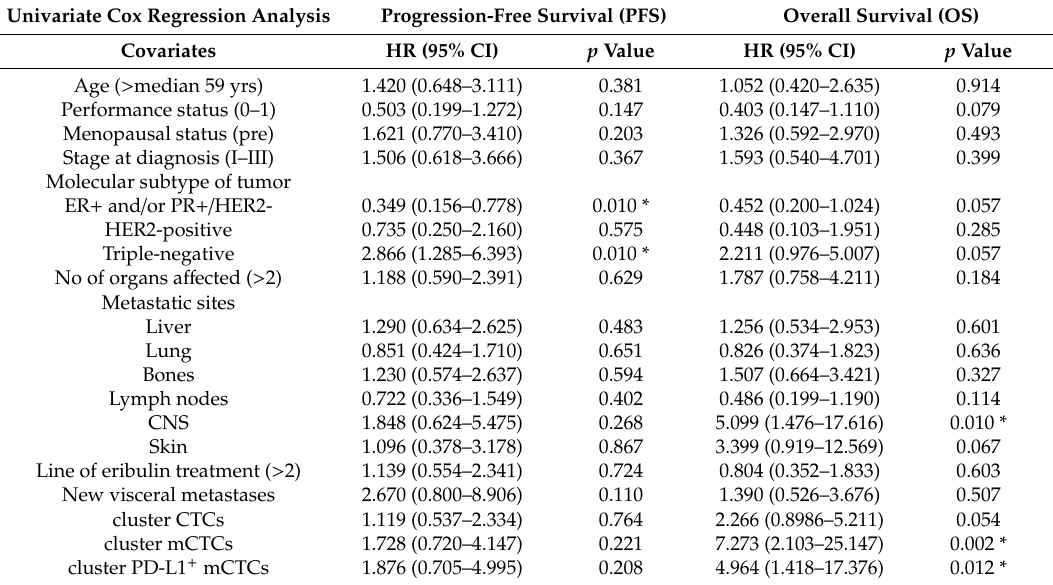
Table 2. Univariate Cox regression analysis for PFS and OS (Patients: n = 34). Univariate Cox Regression